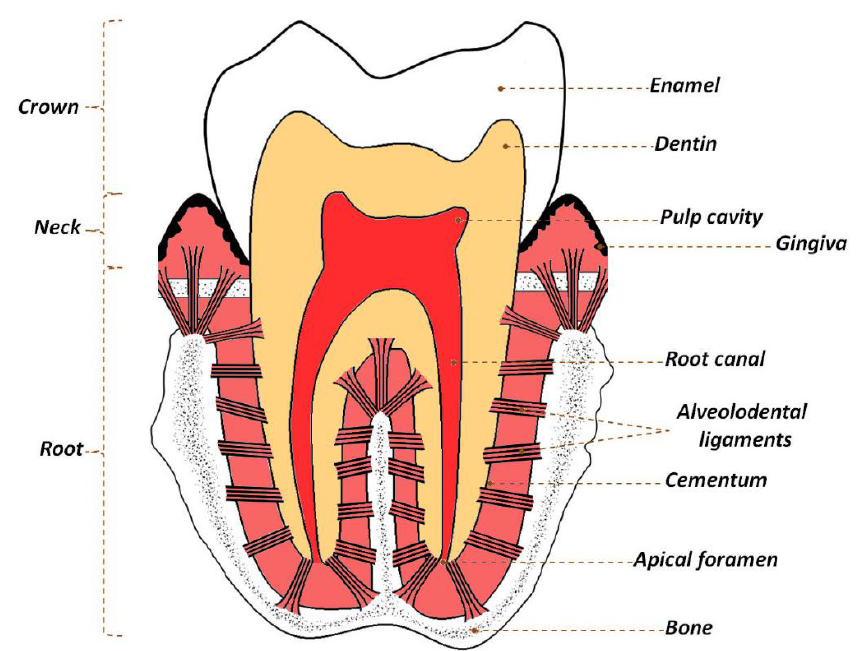
Figure 1. Schematic picture of a molar tooth .